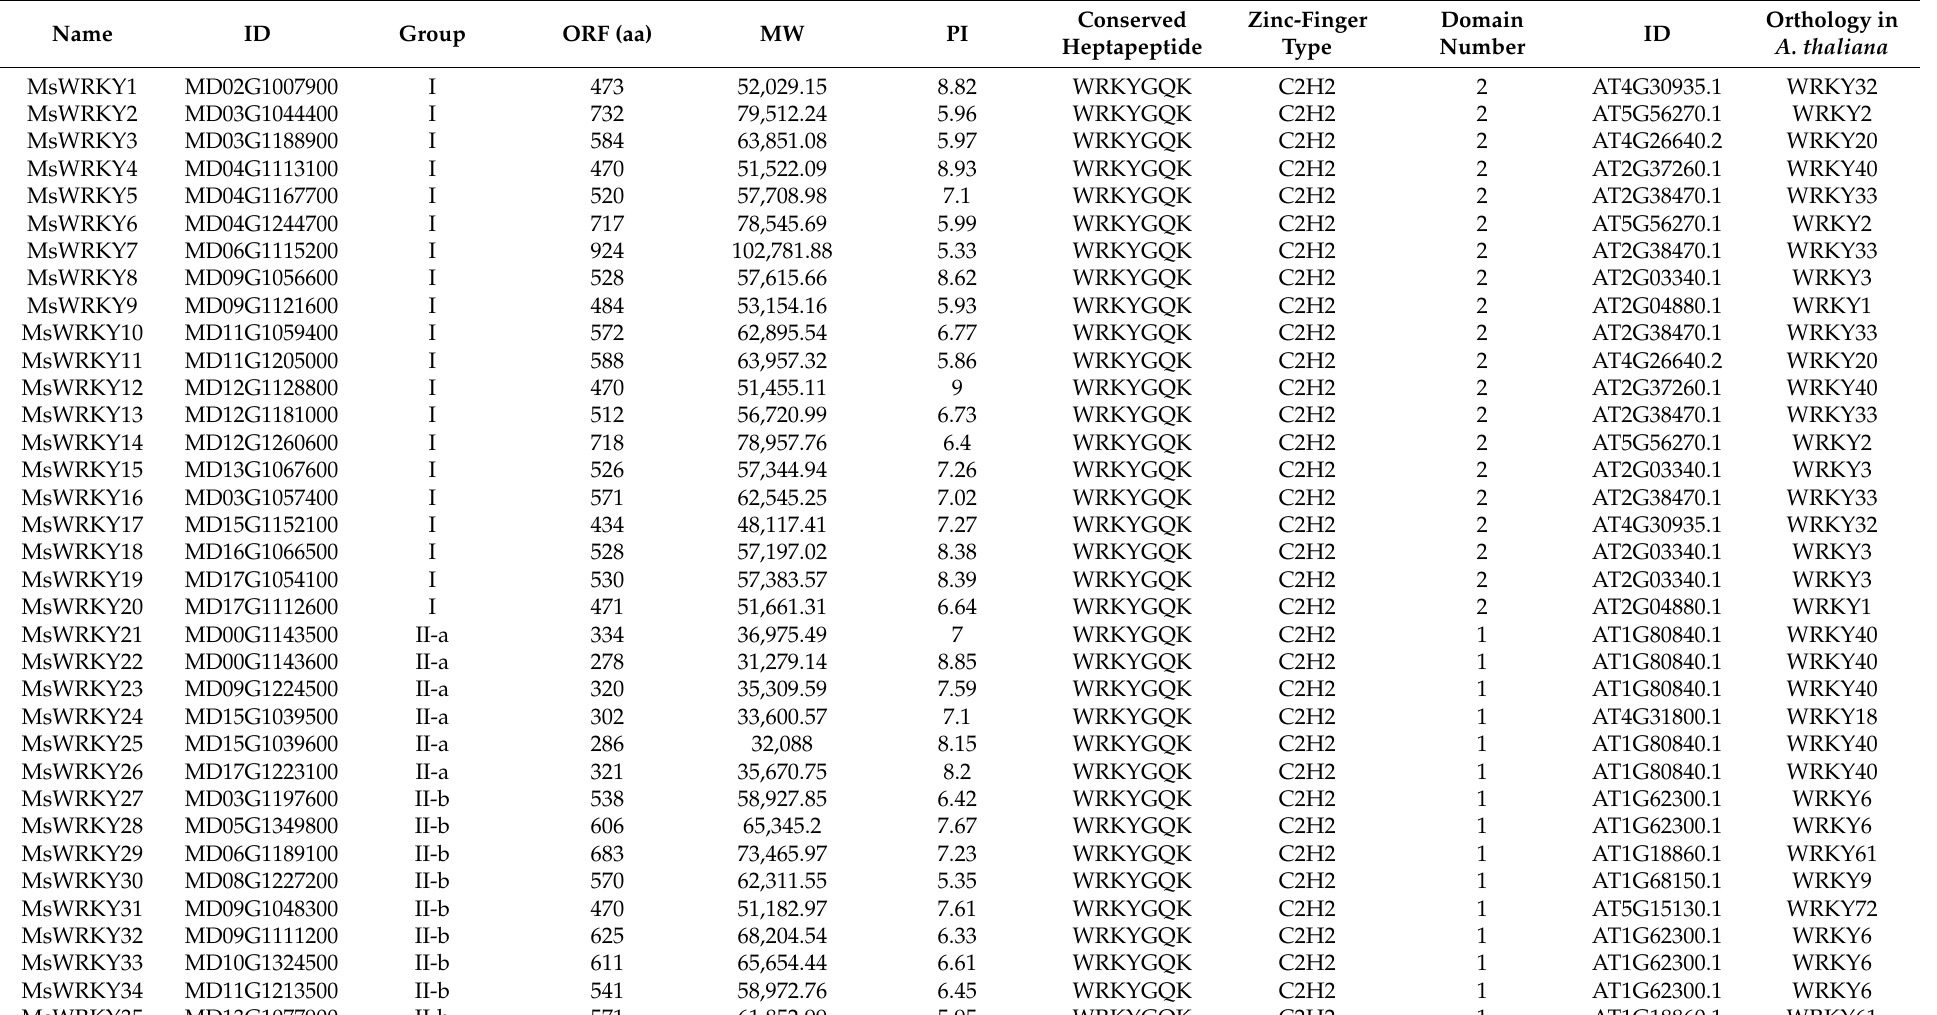
Table 1. List of MsWRKY transcripts identified in M. sieversii